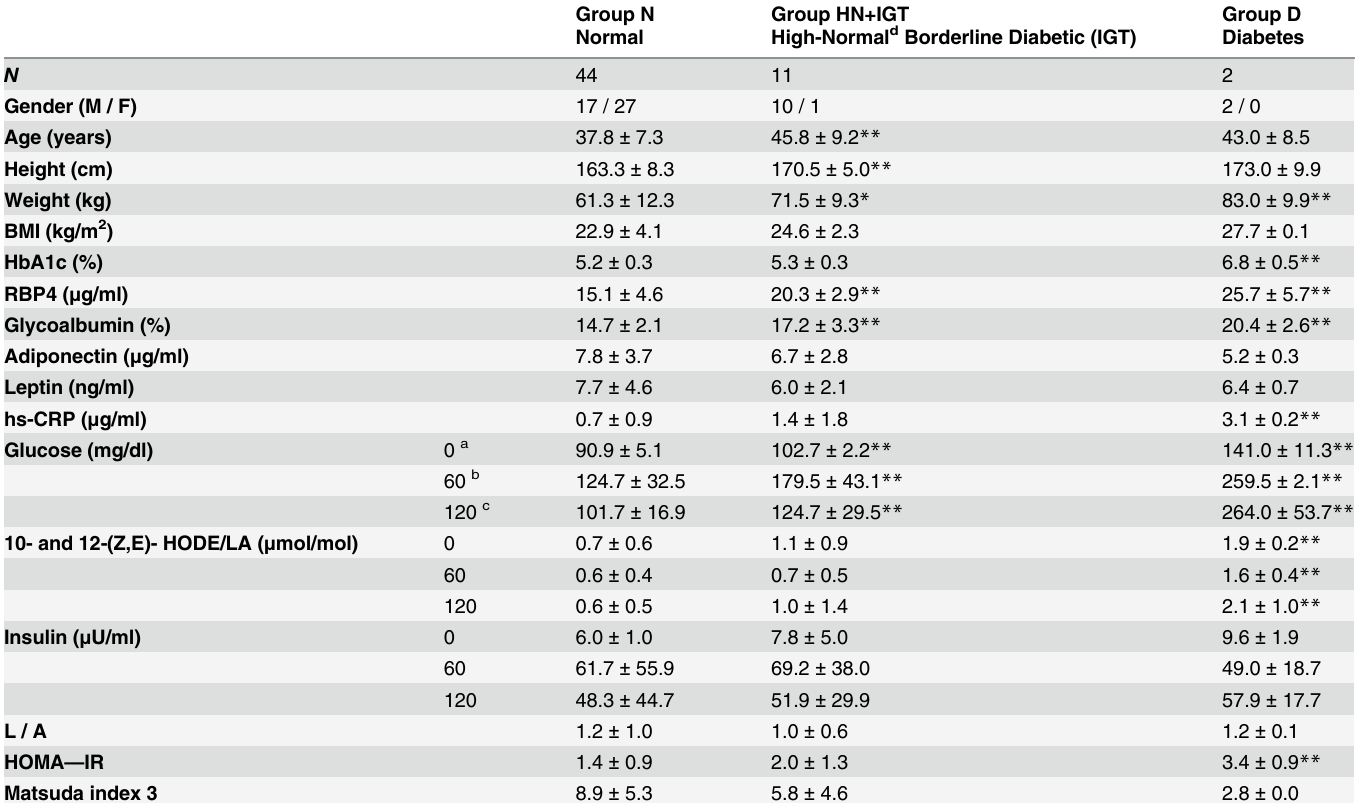
Table 1. Characteristics of subjects at entry into the oral glucose tolerance